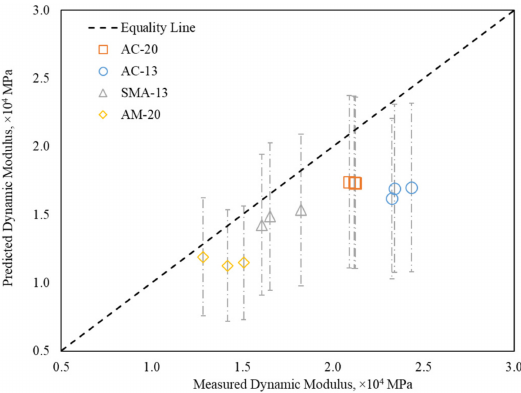
Figure 8. Measured and predicted dynamic